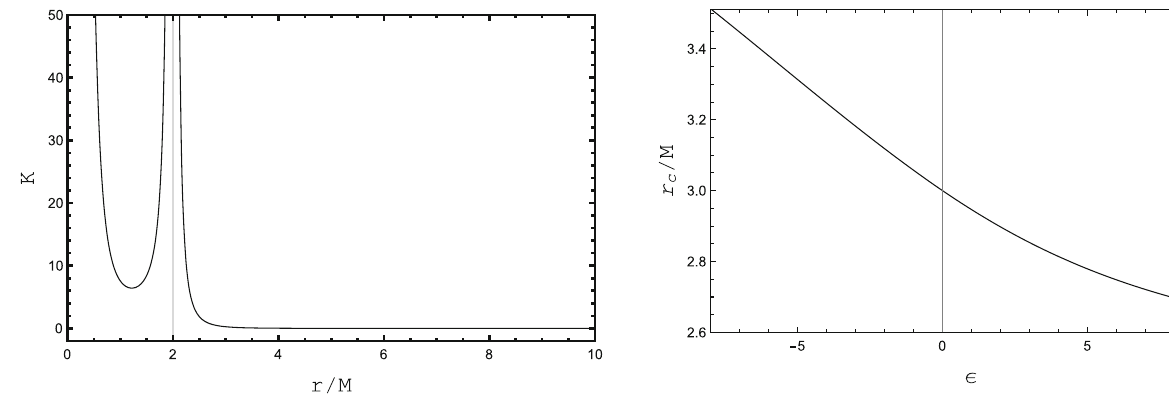
Fig. 3 Light sphere location ( r c ), plotted as a function of the JPBH deformation parameter ε